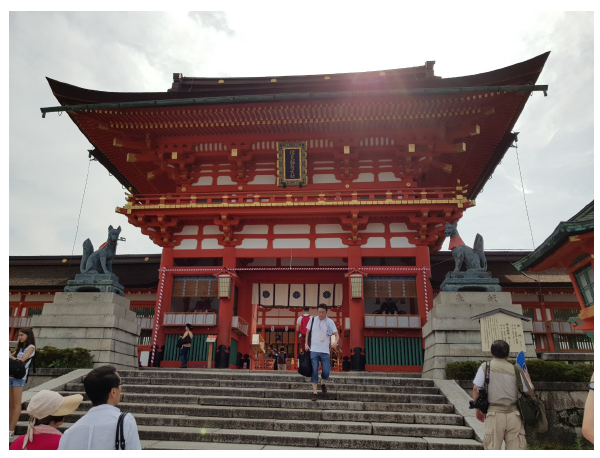
Figure 14: The main shrine